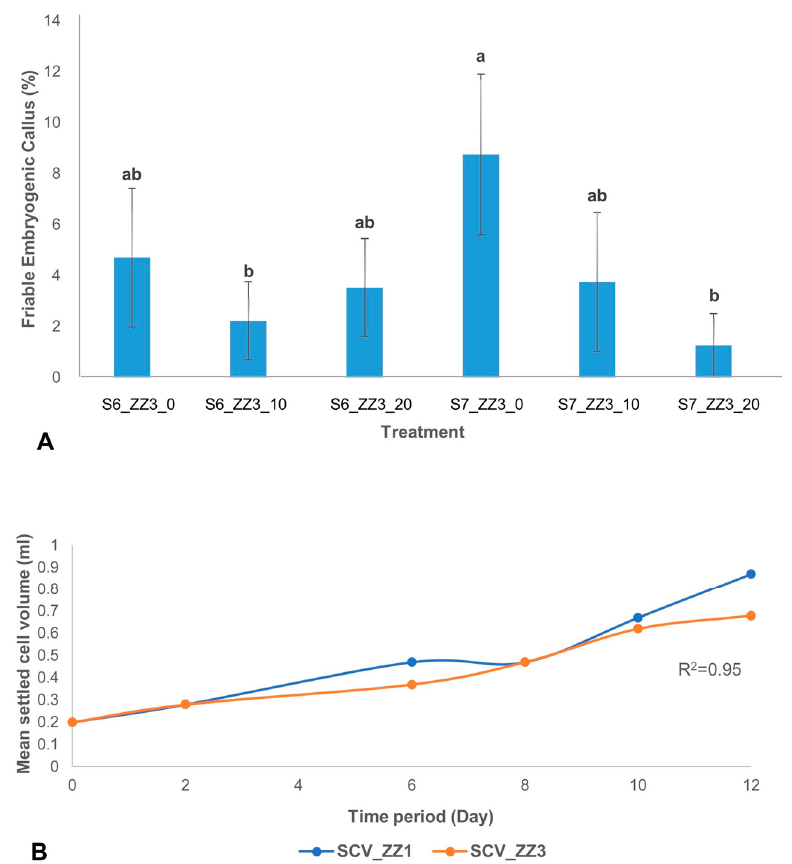
Figure 6. Effect of various media on the development of FEC and proliferation of cell suspension. ( A ) Comparing the effect of various concentration of ascorbic acid on FEC development of Agbagba from scalps at subculture number S6 and S7. The results are presented as percentage mean and standard error of FEC obtained from total number of scalps ( n ≥ 80) cultured at each subculture number (S6 or S7) in ZZ3 medium (ZZ3_0, ZZ3_10, or ZZ3_20) supplemented with 0, 10, and 20 mg/L ascorbic acid. Different letters (a,b) indicate significant differences in treatment at p ≤ 0.05. (B) Cell growth of actively proliferating cells of Orishele on different media (ZZ1 and ZZ3) over 12 days. Data is presented as mean of three replicates ( n ≥ 3).